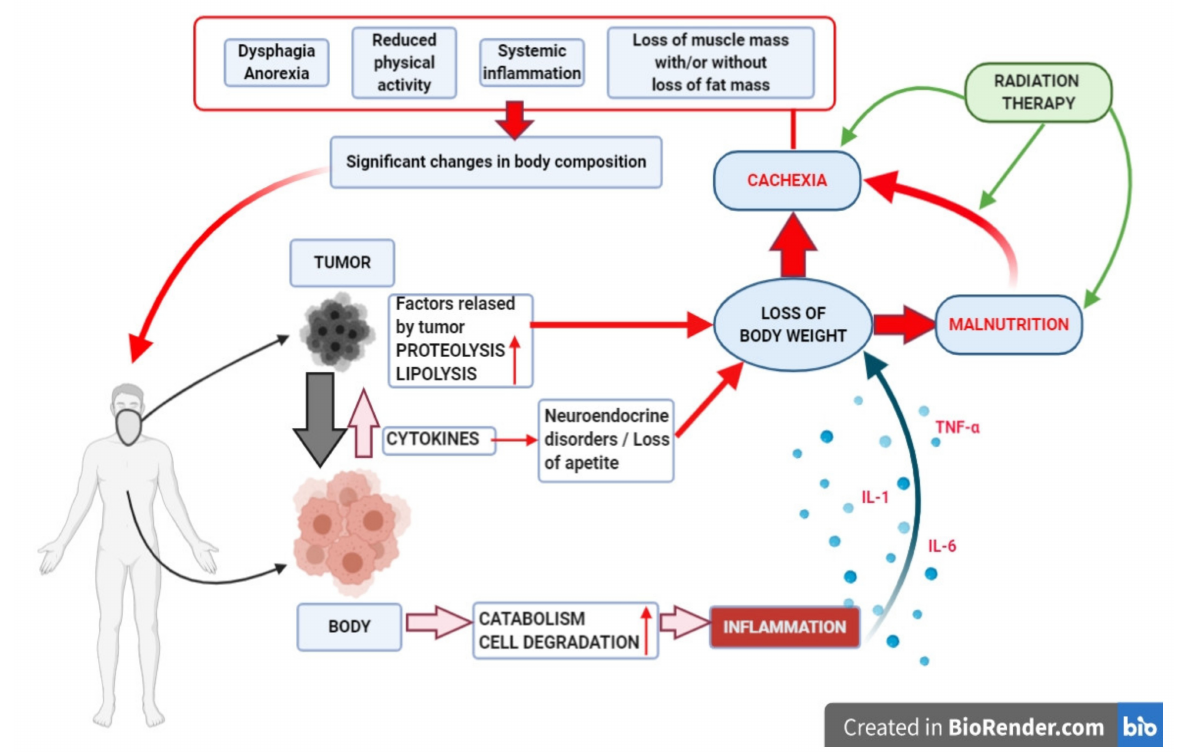
Figure 1. The mechanism of malnutrition and cachexia in neoplastic diseases postulated by most researchers. The classic definition was complemented by the unfavorable impact of radiotherapy (RT) on the nutritional status of the head and neck cancer (HNC) patients (created with the BioRender tool